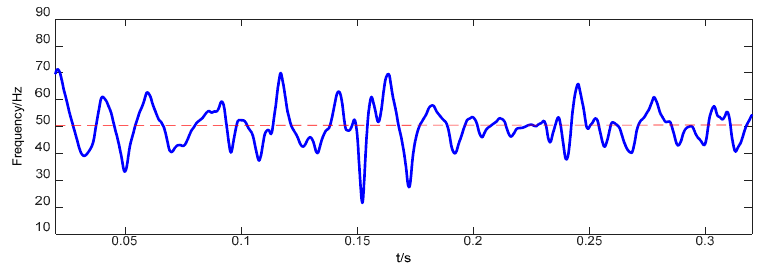
Figure 3. Instantaneous frequency of the IMF corresponding to Figure 2